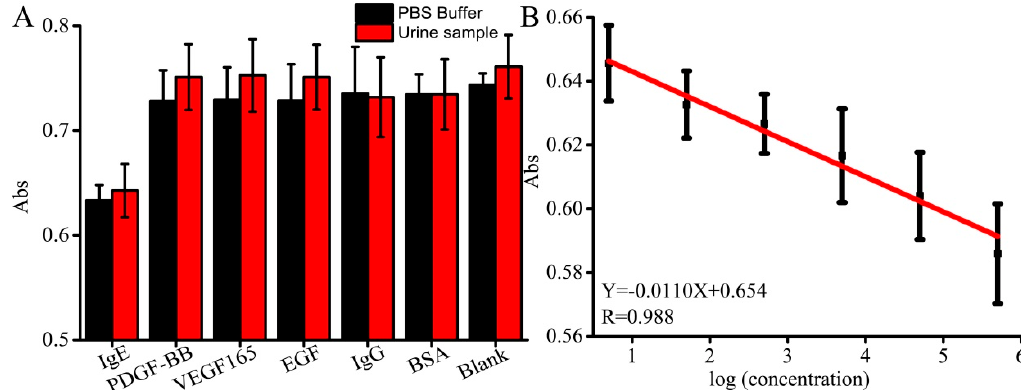
Figure 4. ( A ) Selectivity analysis of FNA-based IgE assay; ( B ) The linear range of the system from 5.0 pg/mL to 5.0 × 10 5 pg/mL. Every assay was done three times in parallel.